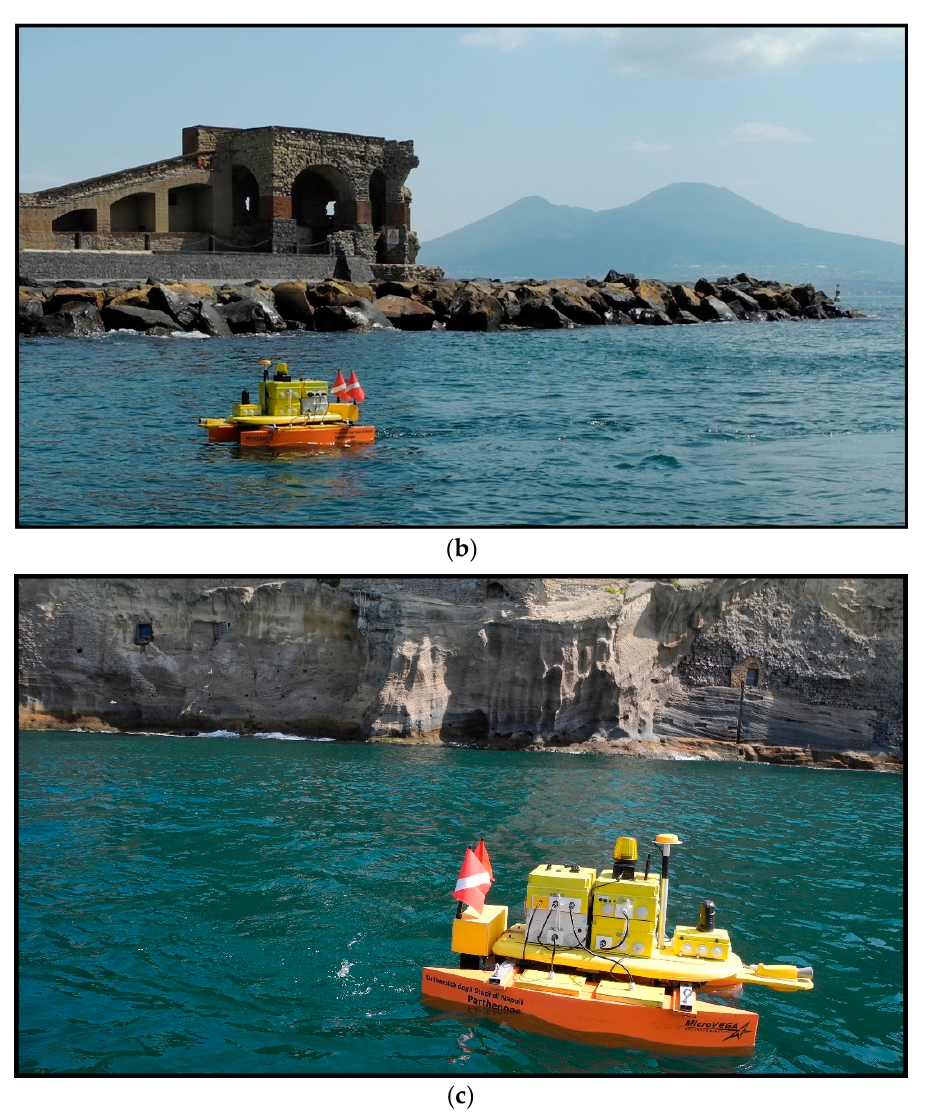
Figure 5. MicroVeGA Unmanned Surface Vessel (USV) during the navigation phases: ( a ) a turning; ( b ) a SE-NW navigation line; ( c ) a NW-SE navigation line.